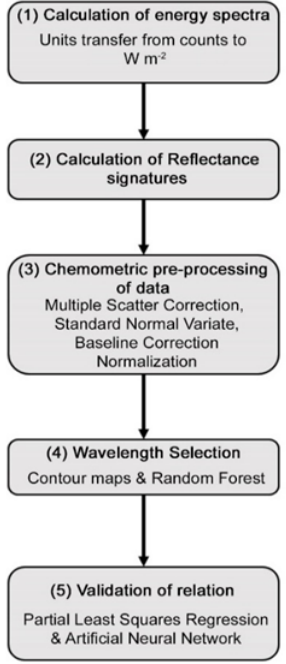
Figure 2. Strategy of chemometric analysis and stomatal conductance index construction. Acronyms used in this figure: SNV = standard normal variate; NDI = Normalized Differential Index; PLS-R = partial least square regression; ANN = artificial neural network.